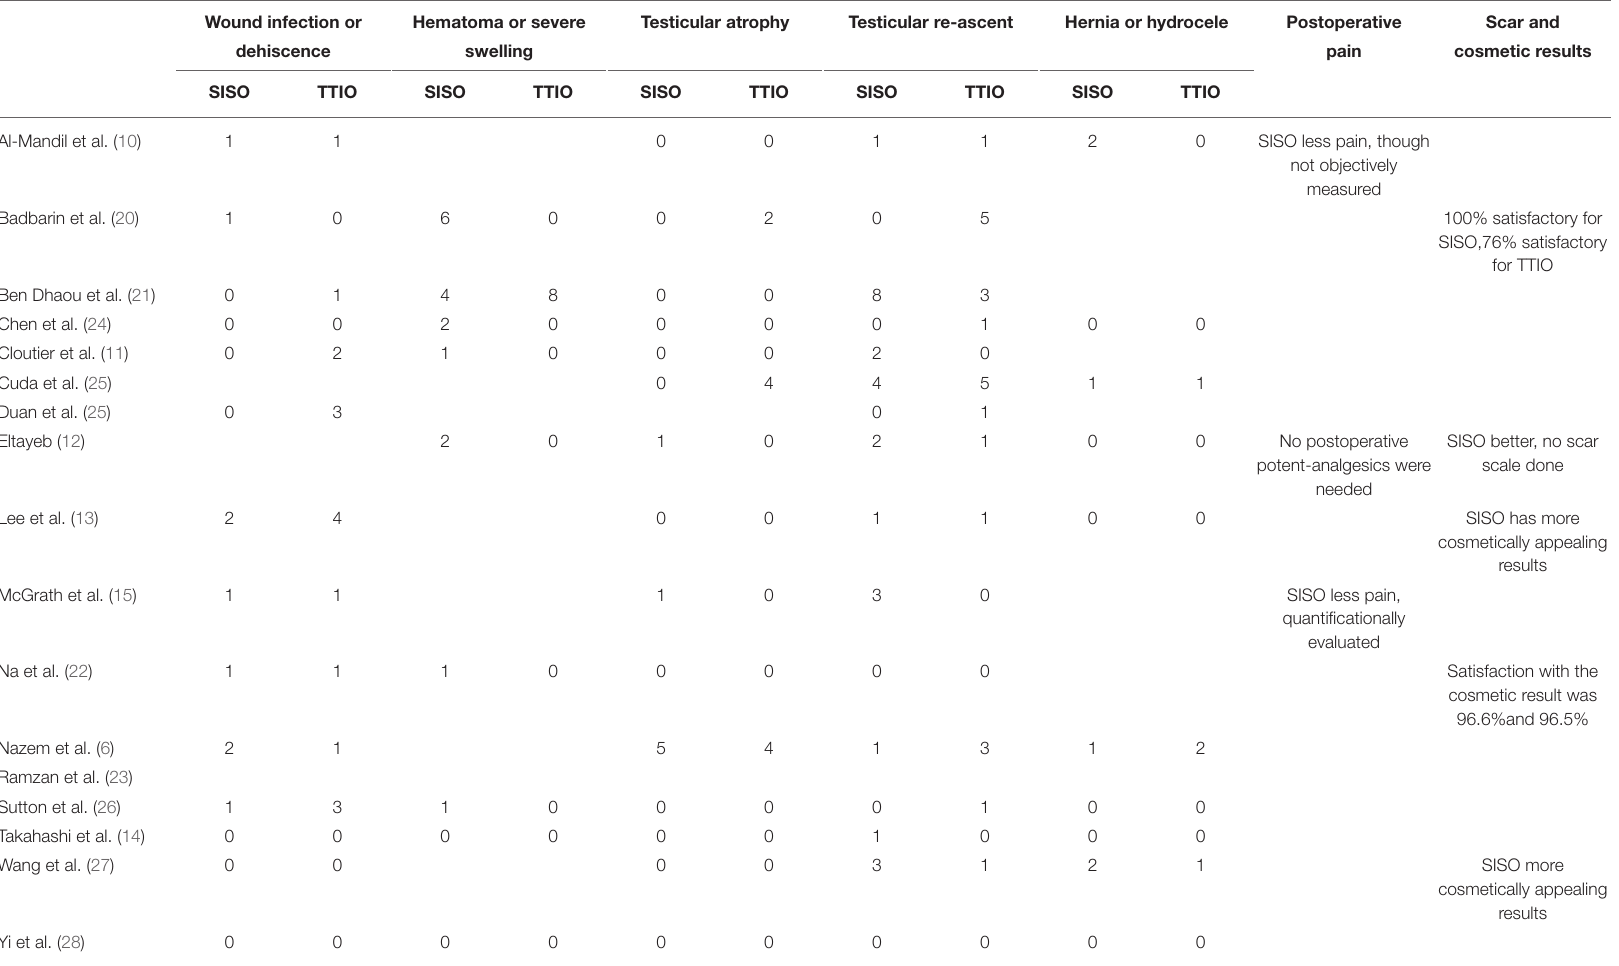
TABLE 3 | The short-term and long-term exact complications, postoperative pain and cosmetic results in these two approaches for primary palpable undescended